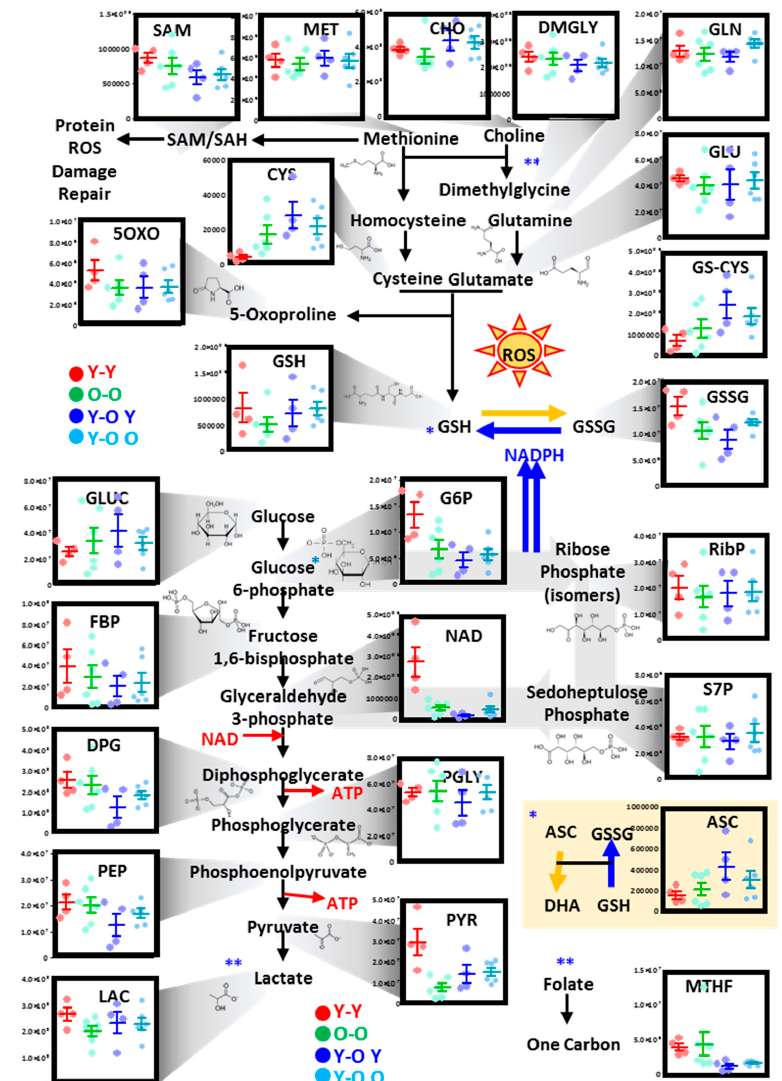
Figure 6. Alterations of RBC glycolysis, the pentose phosphate pathway, and glutathione and one-carbon metabolism in isochronic and heterochronic parabiotic mice. Dots represent distinct biological replicates for isochronic young (Y)–young (red) or old (O)–old (green), or heterochronic Y–O mice with blood being drawn from the young mouse (blue) or the old mouse (light blue). * cross-talk between glutathione homeostasis and glyoxylate pathway. ** cross-talk between methionine and one-carbon metabolism.